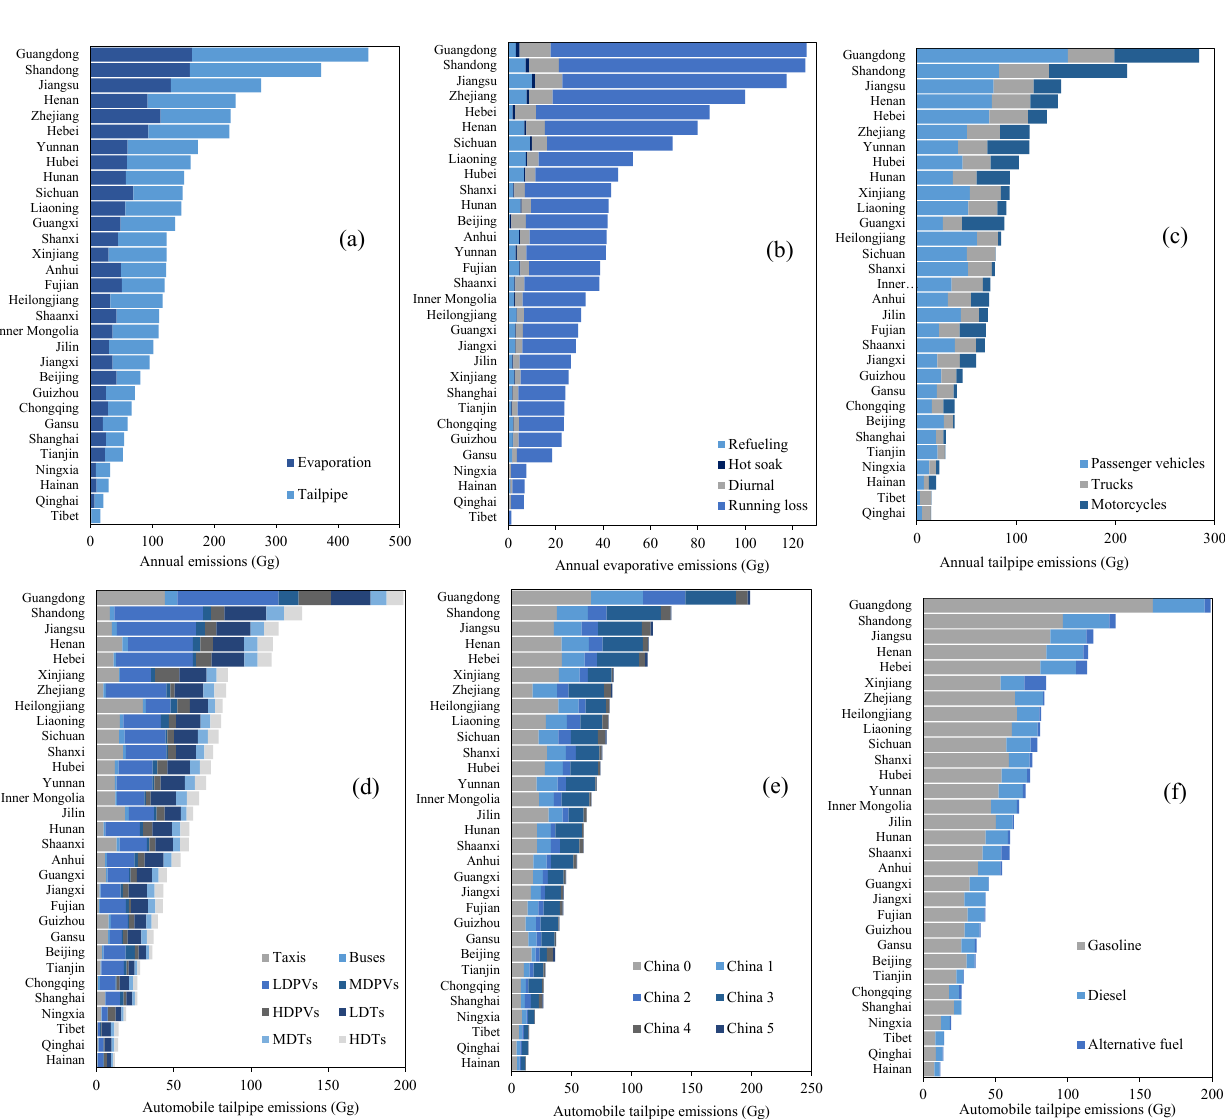
Figure 4. Provincial VOC emissions from vehicles in 2015: (a) total emission amount classified by emission sources; (b) evaporation emission amount classified by evaporation processes (motorcycles excluded); (c) tailpipe emission amount classified by vehicle types; (d– f) tailpipe emission amounts classified by detailed categories, emission certification levels and fuel type (motorcycles